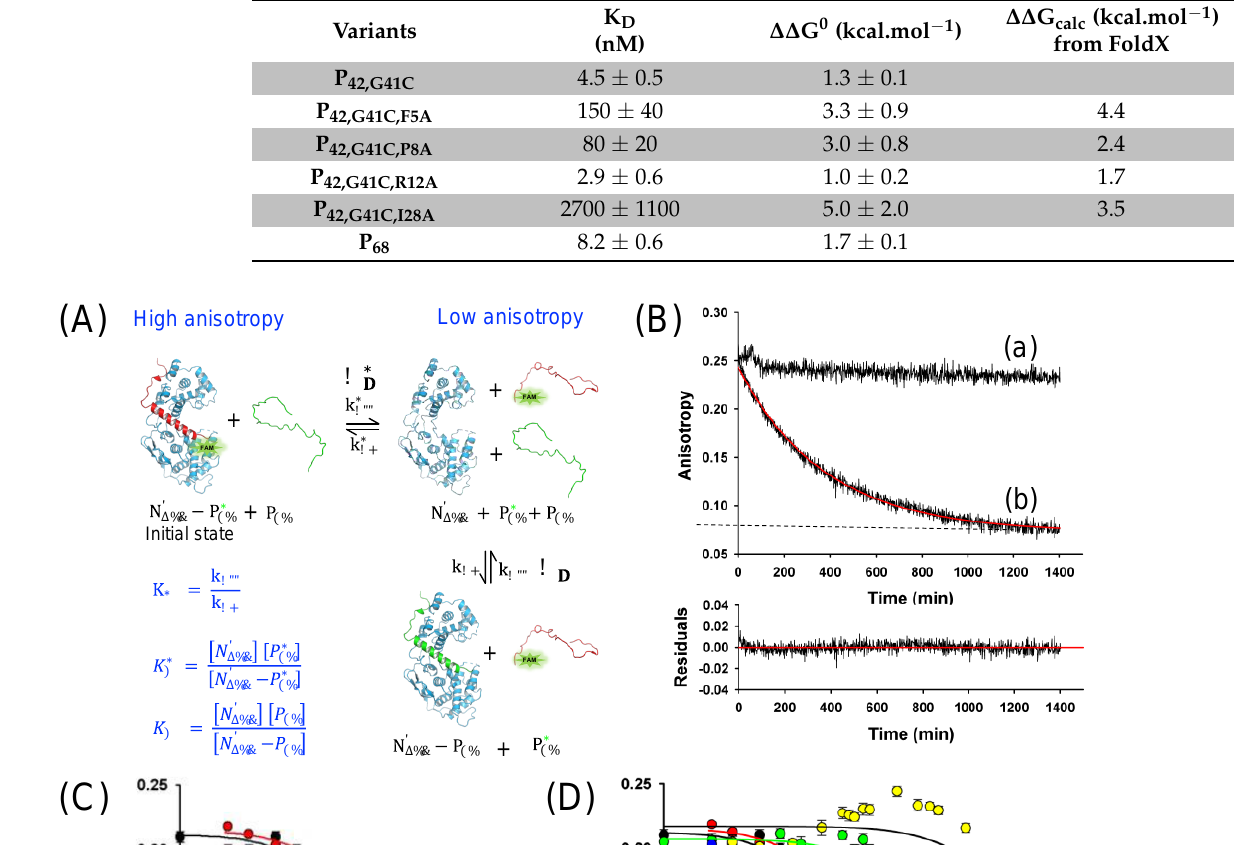
Table 2. Dissociation constants determined by fitting the equilibrium competition binding curves. The K D values were determined by fitting the curves in Figure 4D to the competition model shown in Figure 4A and fixing K D * = 0.5 nM. The ∆∆ G 0 values were calculated by reference to the K D * value for FAM labeled P 42 using ∆∆ G 0 = − RT ln (K D */K D ) and ∆∆ G calc are the values predicted by FoldX from the crystal structure.